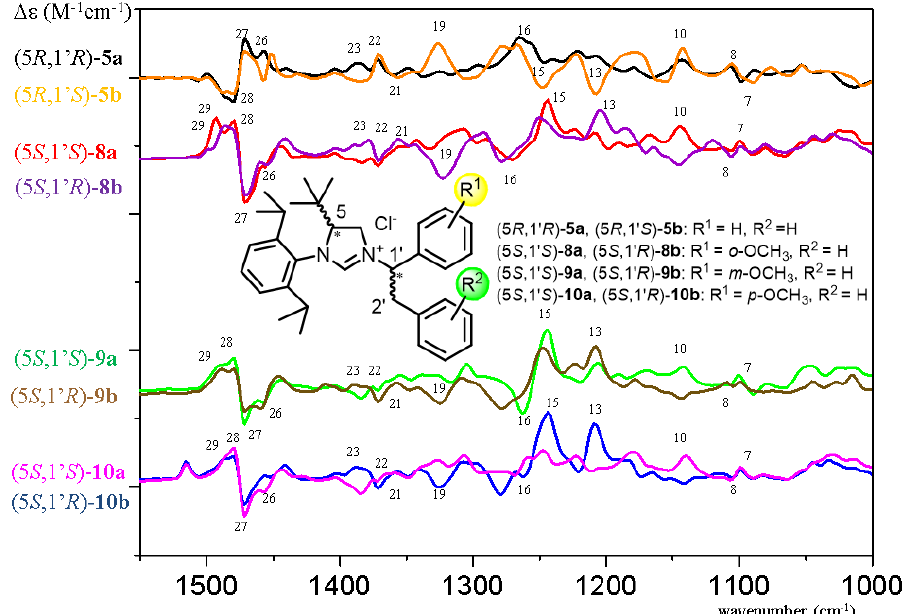
Figure 3. Overlapped experimental VCD spectra of the C ‐ 1 ′ epimeric reference compounds (5 R ,1 ′ R ) ‐ 5a and (5 R ,1 ′ S ) ‐ 5b and their methoxy ‐ substituted analogues (R 1 = OMe) (5 S ,1 ′ S ) ‐ 8–10a and (5 S ,1 ′ R ) ‐ 8–10b containing the methoxy group in different positions.